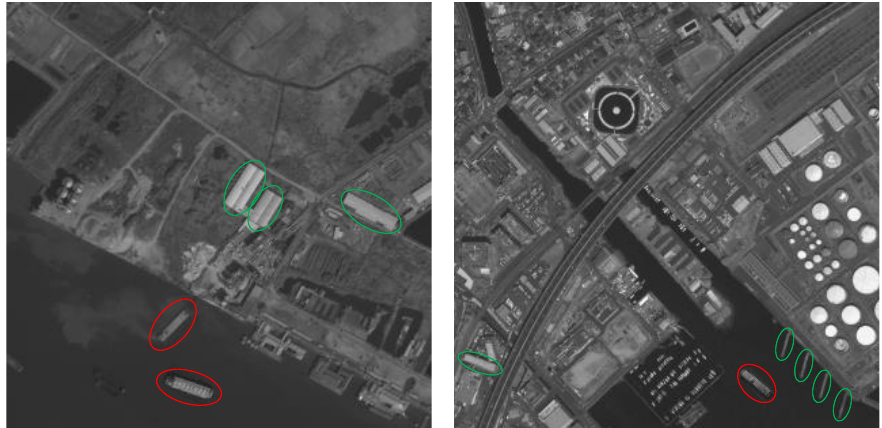
(d) Figure 3. Some examples of optical remote sensing images. The green circles denote ship-like objects on